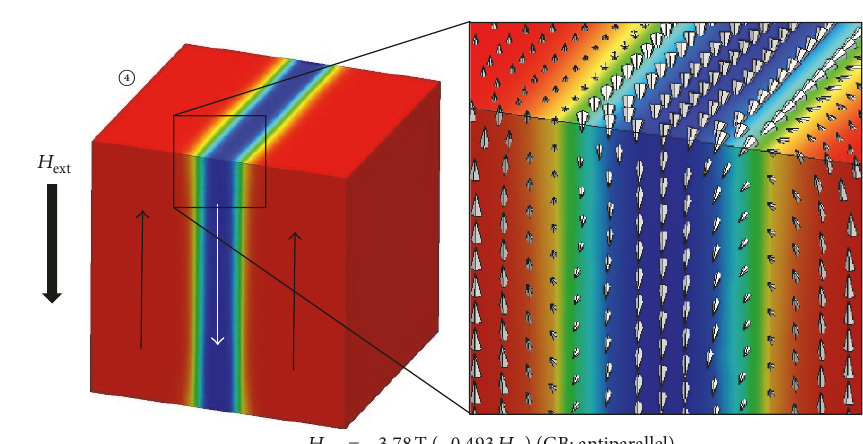
GB is antiparallel to one of the adjacent grains, until being at a high external field value of 6.45 T (Figure 17 B ). The high value of the necessary external field is originated by the large formation energy of a N´eel DW due to the strong stray field occurring along the whole interfaces between the GB and the neighbouring